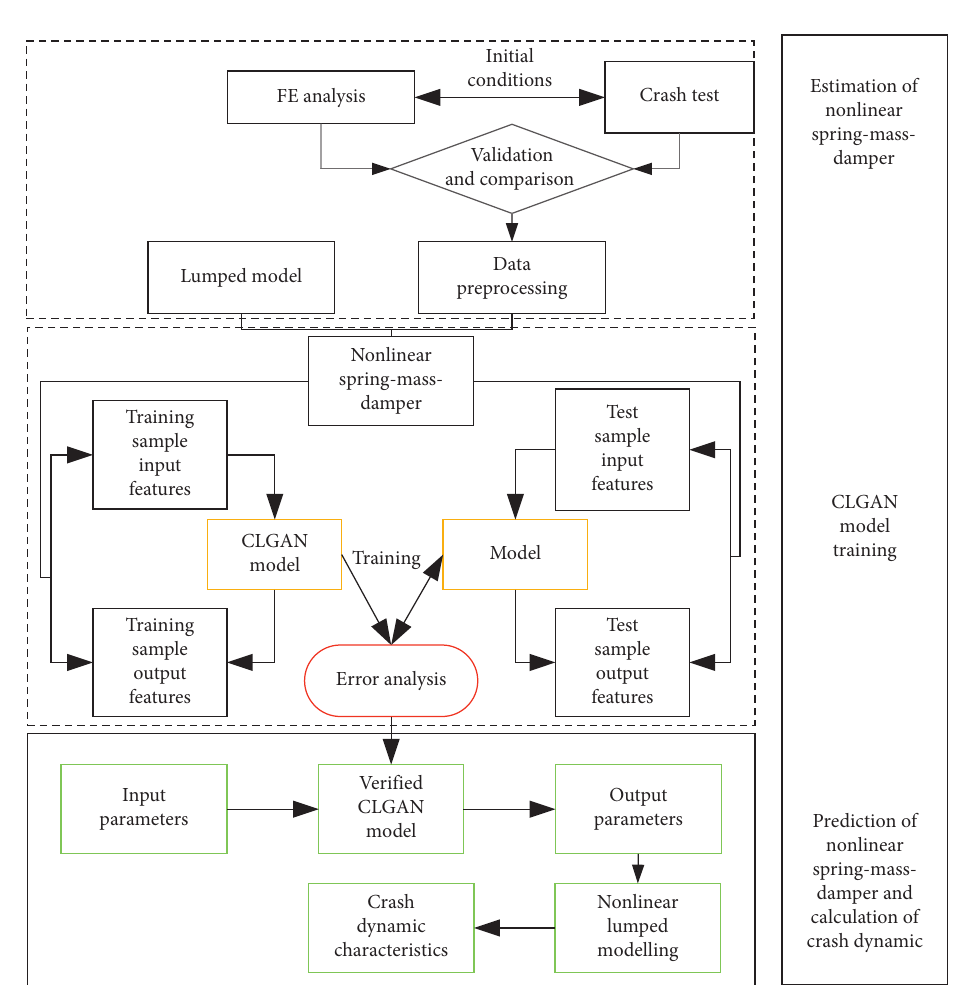
Figure 4: Modeling flowchart of the nonlinear lumped